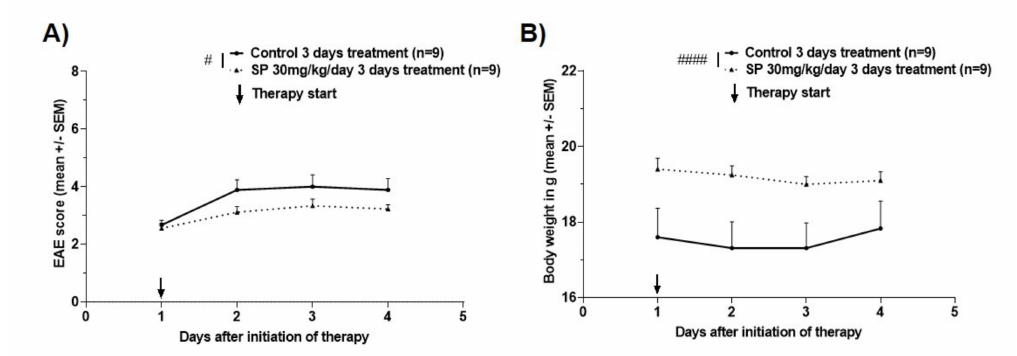
Figure A2. ( A ) clinical disease course of MOG 35-55 EAE in C57BL / 6JRj wild type mice treated for